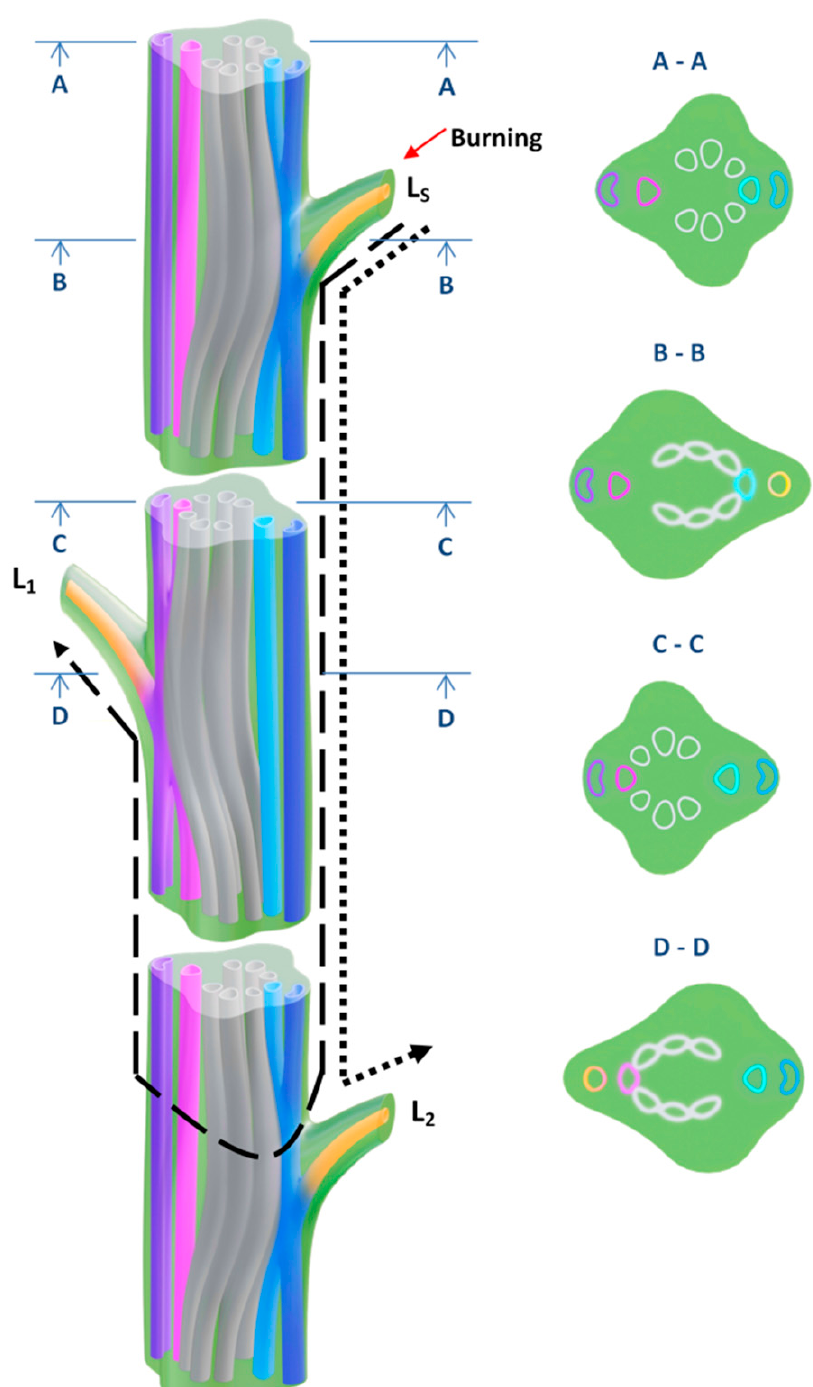
Figure 6. Hypothetical scheme of long-distance signal propagation. Three-dimensional diagram of the vascular bundles in the stem of Pisum sativum and schematic cross sections of internodes and nodes. All the changes in the vascular bundle system occur at the nodal region and this is the reason for omitting the internodes in the figure. Dotted line indicates the pathway of long-distance signal from the stimulated leaf (L S ) to the second unstimulated leaf (L 2 ). Dashed line indicates the pathway of long-distance signal from the stimulated leaf (L S ) to the first unstimulated leaf (L 1